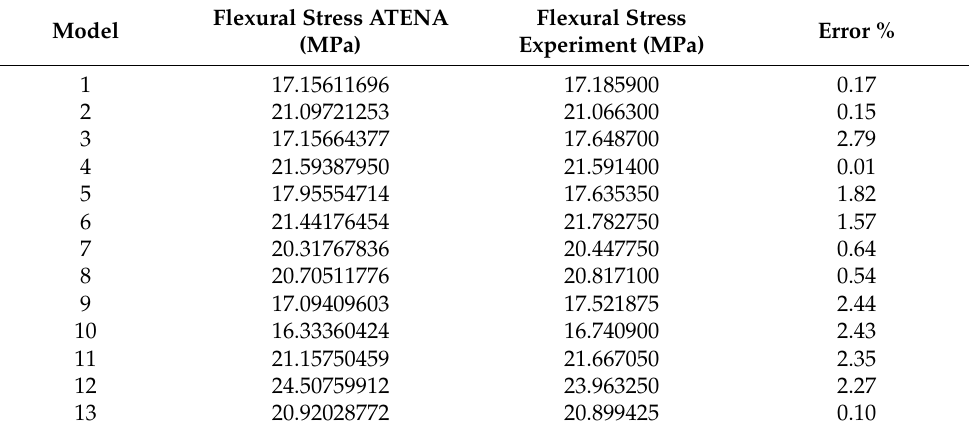
Figure 4. Flexural stress verification. Table 5. Error estimation for flexural stress.